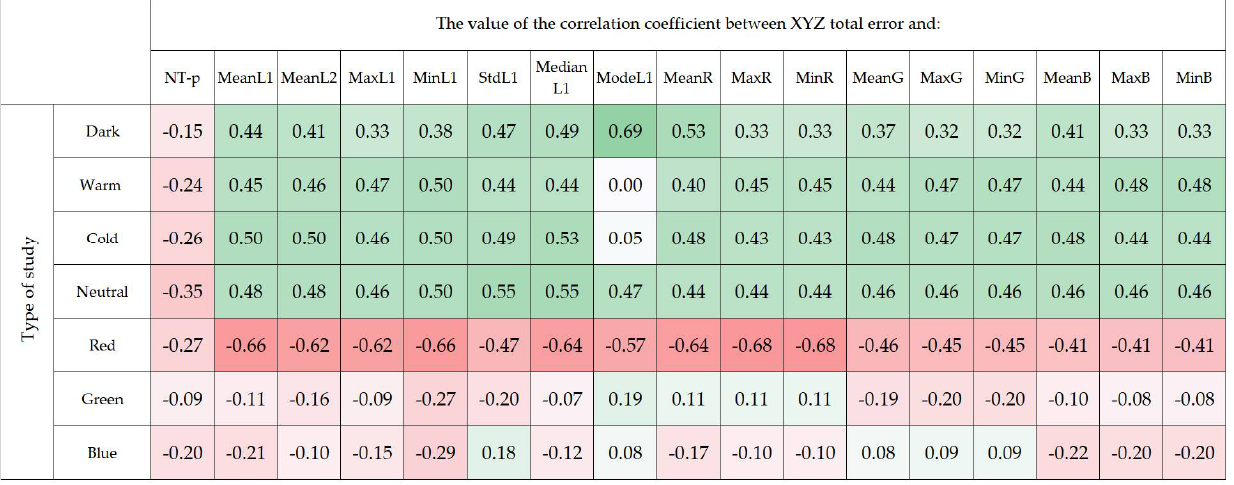
Figure 18. The value of the correlation coefficient between XYZ total error and the F-point features. Figure 18 confirms the fact of a low inverse correlation between the XYZ total error and the number of tie-points regardless of the study type. In the case of the Dark, Warm, Cold and Neutral studies, it is possible to state that there was the mean correlation between the XYZ total error and the luminosity and spectral response values for R, G and B. An interesting fact is that the correlation is clearly inverted if the scene is illuminated with a monochromatic light source (Red, Green, Blue studies). The strongest inverse correlation is demonstrated by the comparisons made for the Red study. The next figure (Figure 19) presents the comparison of the number of tie-points with other F-point features by study.